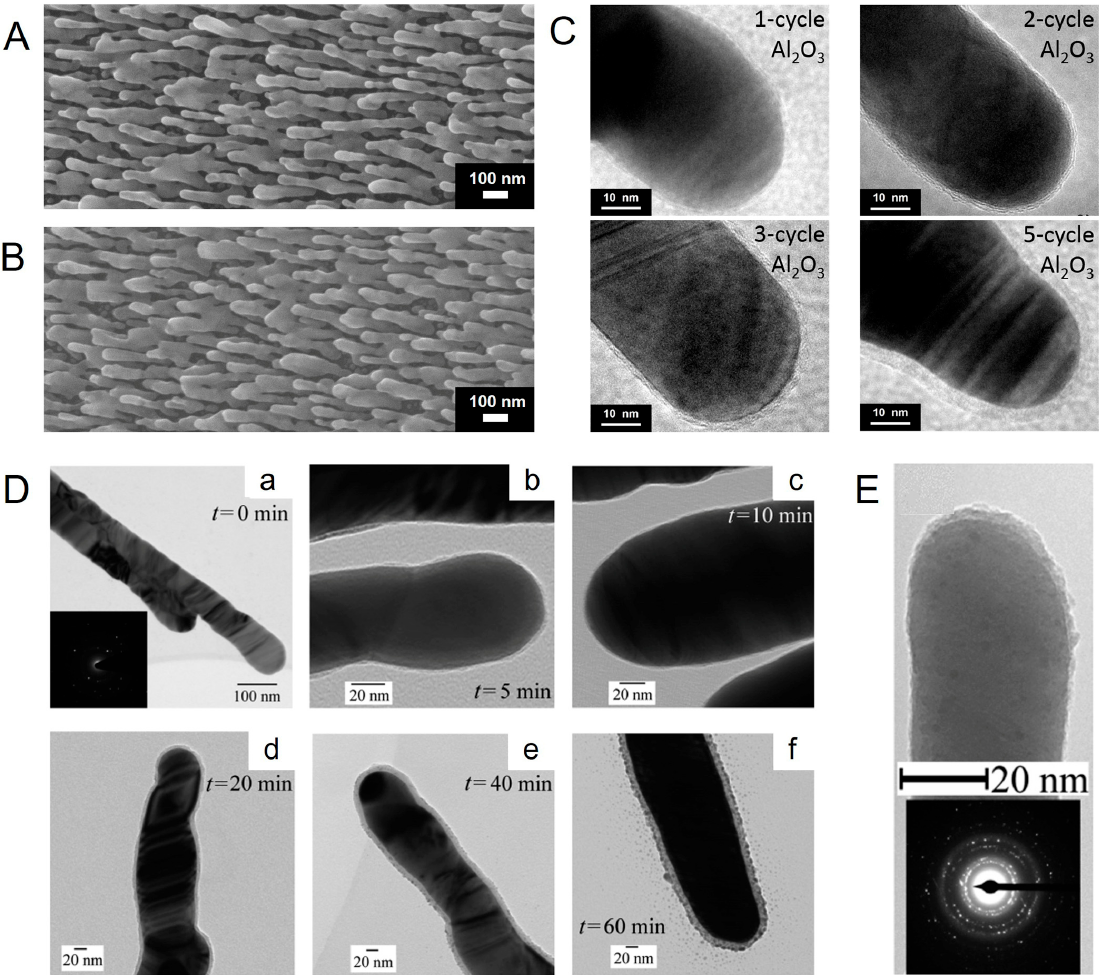
Figure 1. ( A ) Scanning electron microscopy (SEM) image of a pristine AgNRs substrate deposited via the OAD method at the incident angle of 86°, the deposition rate of 0.75 nm/s to a total thickness of 500 nm; ( B ) SEM image of AgNRs coated with an Al 2 O 3 layer by 5 atomic layer deposition (ALD) cycles; ( C ) Transmission electron microscopy (TEM) images of AgNRs coated with Al 2 O 3 layers by 1, 2, 3, and 5 ALD cycles, respectively (Reprinted with permission from [49]); ( D ) TEM images of AgNRs before and after coating with SiO 2 layers for different reaction times (Reprinted with permission from [58]. Copyright (2011) American Chemical Society); ( E ) TEM image of a single AgNR with TiO 2 capping primarily at the nanorod tip (top), and electron diffraction pattern of multiple AgNRs (bottom) (Reprinted with permission from [50]. Copyright (2014) AIP Publishing LLC).